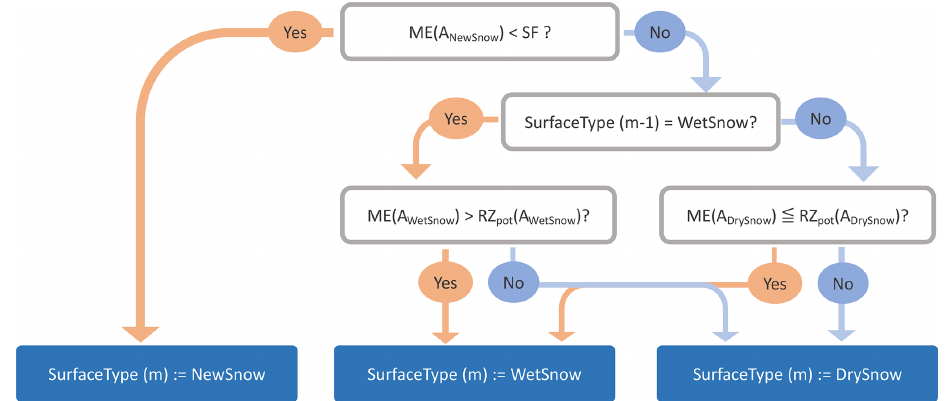
Figure 3. Schematic of the algorithm which selects the surface type (NewSnow, DrySnow or WetSnow) for each grid point and month m .